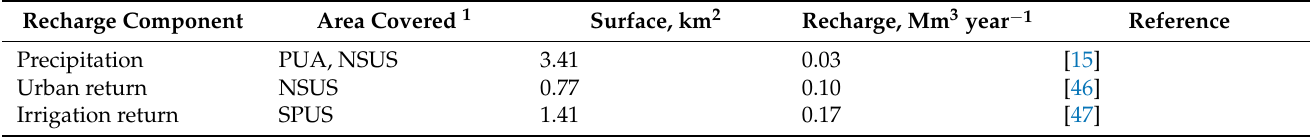
figure is 0.03 Mm 3 year − 1 higher than average groundwater discharge. Table 4. Groundwater recharge in the